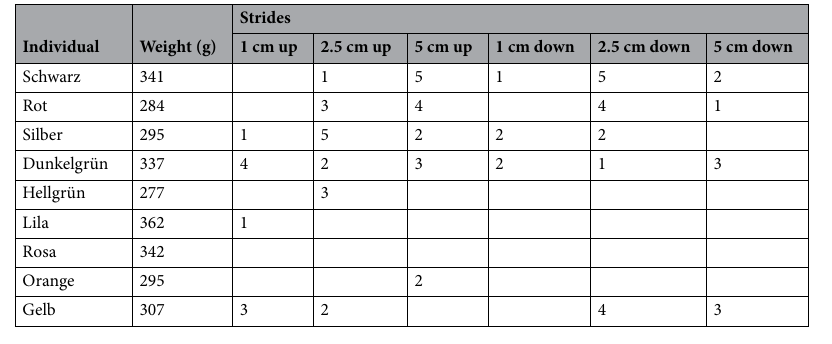
Table 2. Animals and